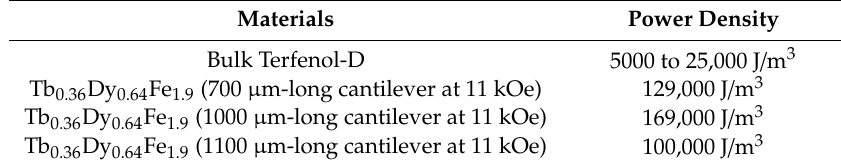
Table 2. Energy density of bulk Terfenol-D and electrochemical deposited Tb 0.36 Dy 0.64 Fe